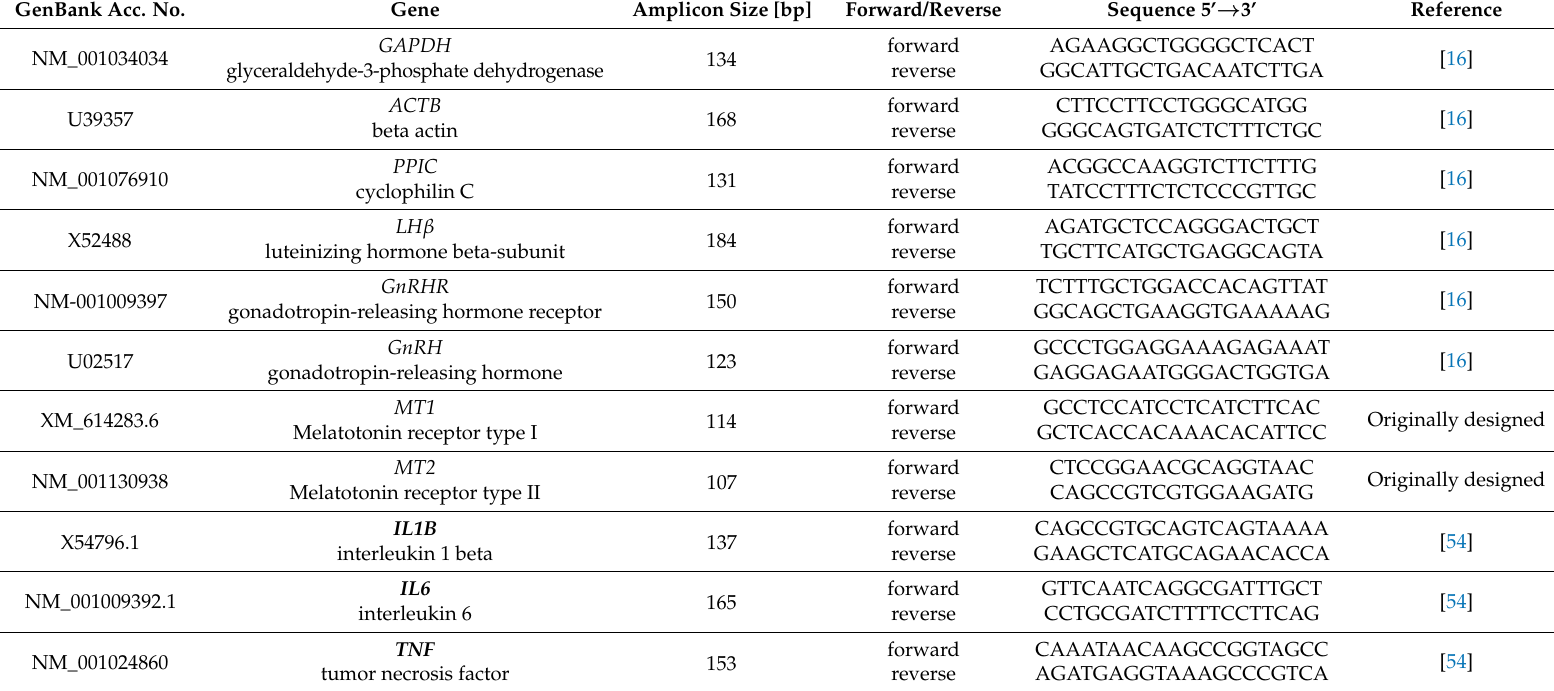
Table 2. All genes analyzed by Real-Time PCR are listed with their full names and abbreviations. GenBank Acc.